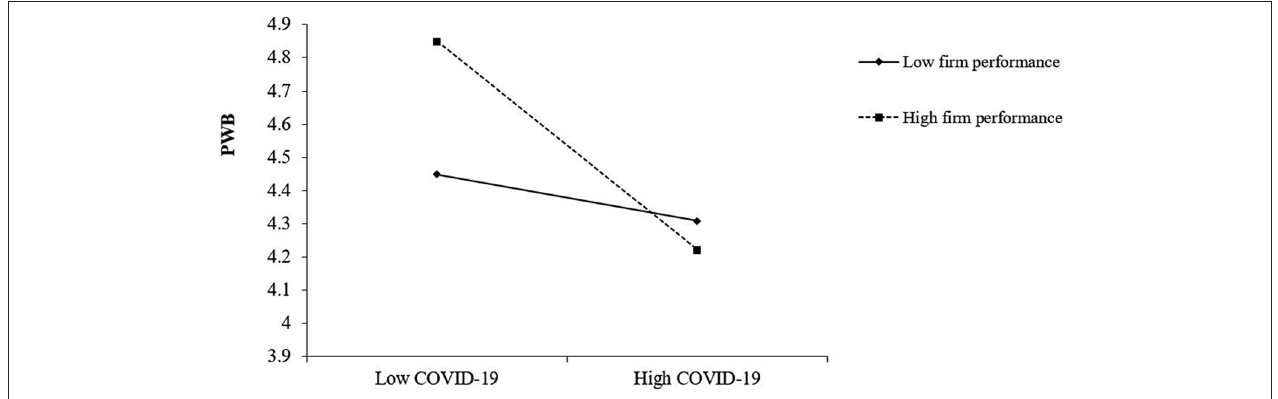
FIGURE 2 | The interaction between COVID-19 and firm performance on